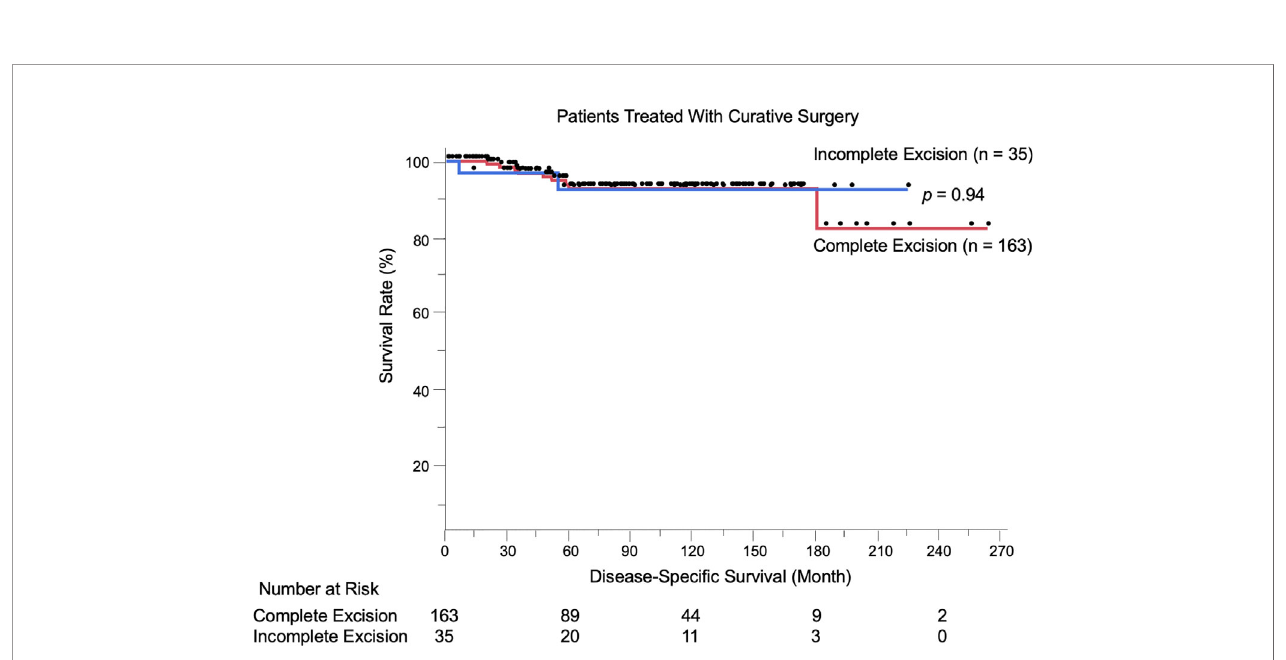
FIGURE 3 | Kaplan-Meier disease-speci fi c survival curves of the 198 patients treated with curative surgery strati fi ed by achievement of complete excision. Incomplete excision was not correlated with worse survival compared to complete excision ( p = 0.94).The number at risk is also